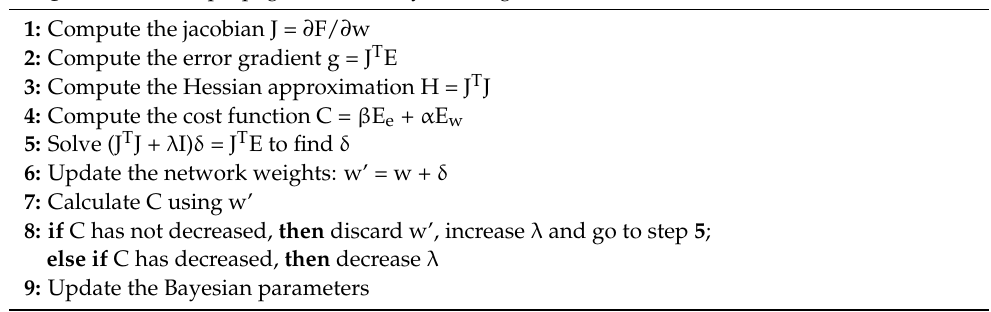
Algorithm 2 . Backpropagation with Bayesian regularization.